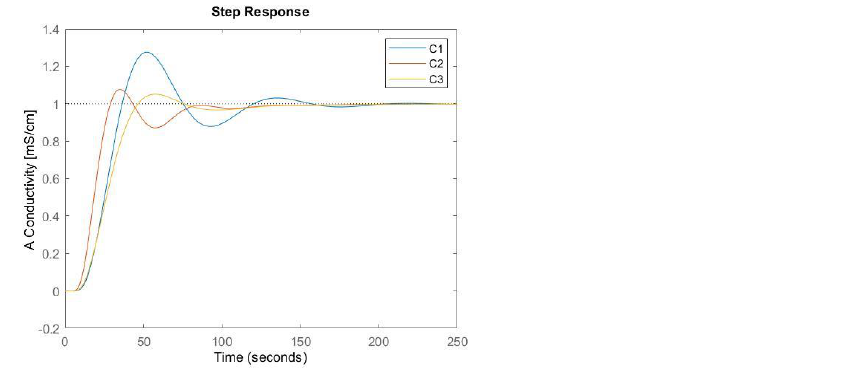
Figure 9. Step responses of the closed-loop system for the three designed FO-PI controllers. Table 3. The imposed performances and the resulting FO-PID controller parameters.